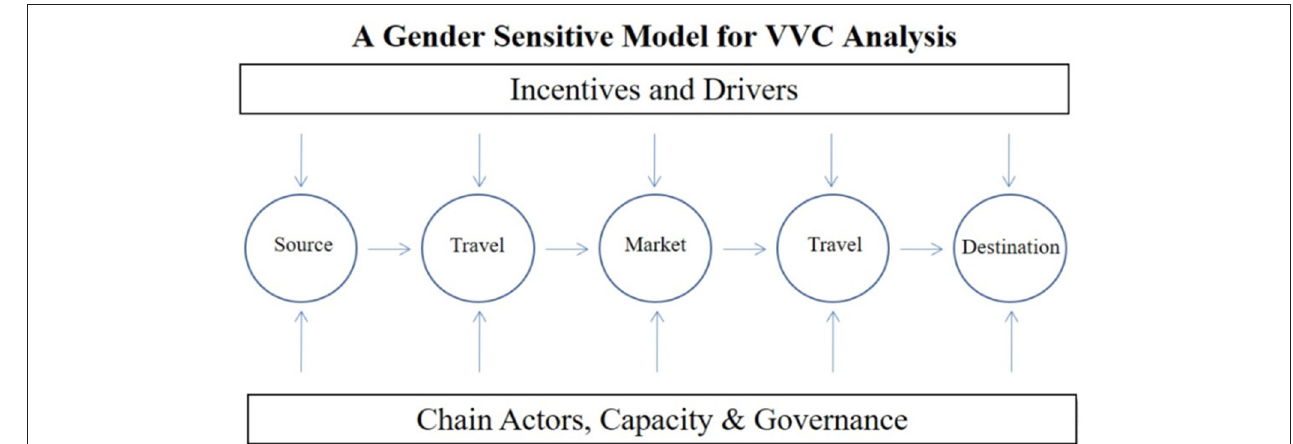
FIGURE 2 | Vaccine value chain demonstrating linear movement of vaccine from manufacturer to end user.